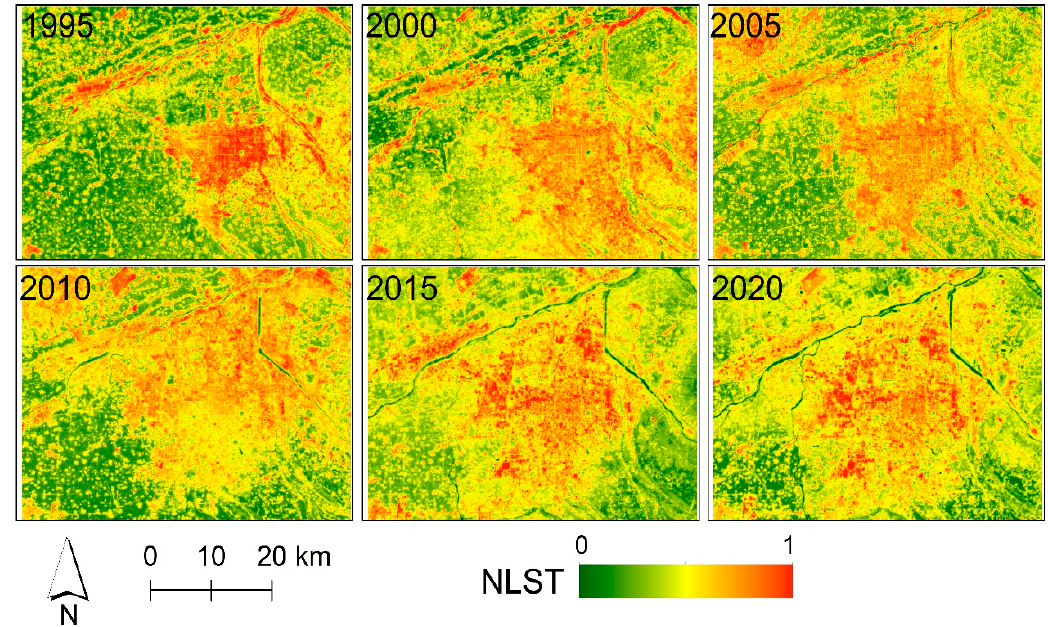
Figure 3. Normalized land surface temperature in the study area for six time periods from 1995 to